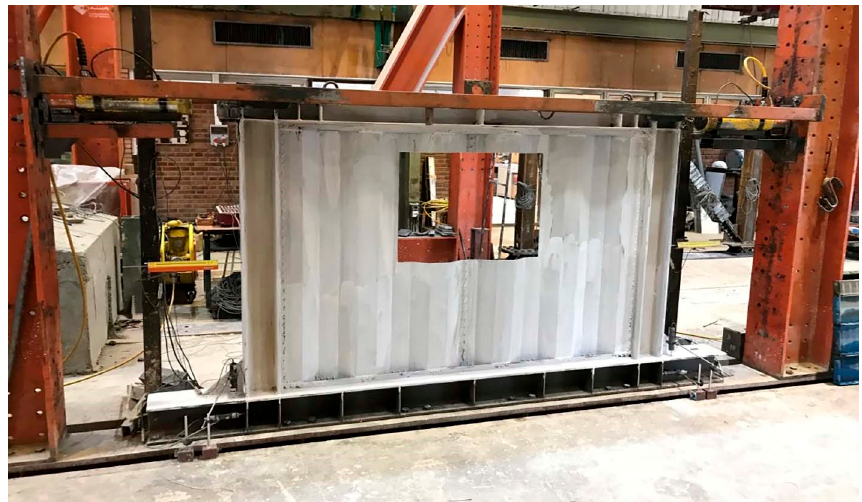
Figure 6. Test setup of specimen 1.